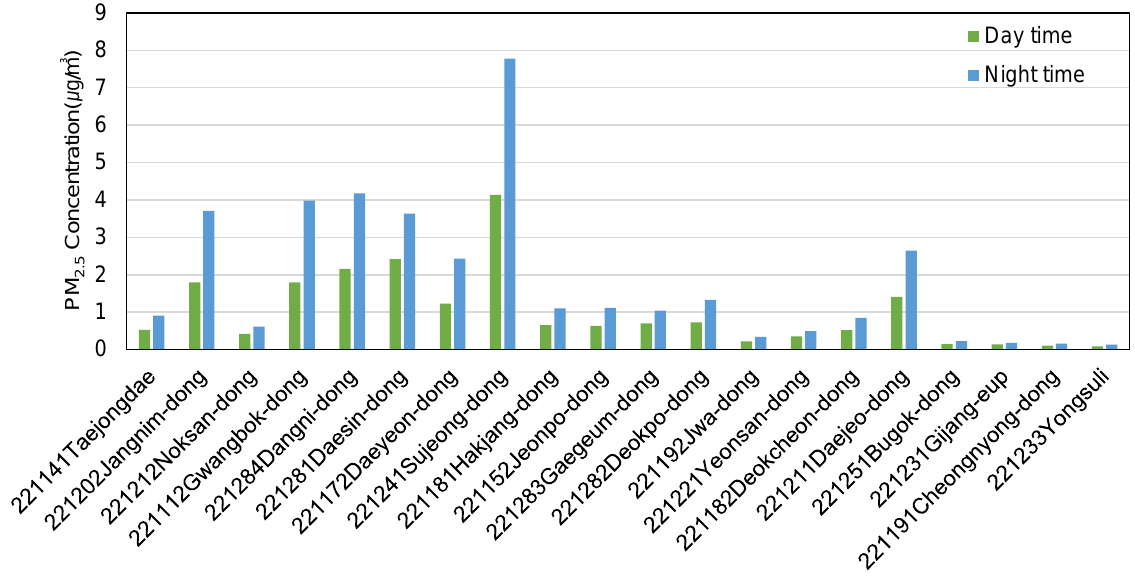
Figure 8. The horizontal distribution of wind vector at a 1 km resolution in the Busan area (1 July 2020).